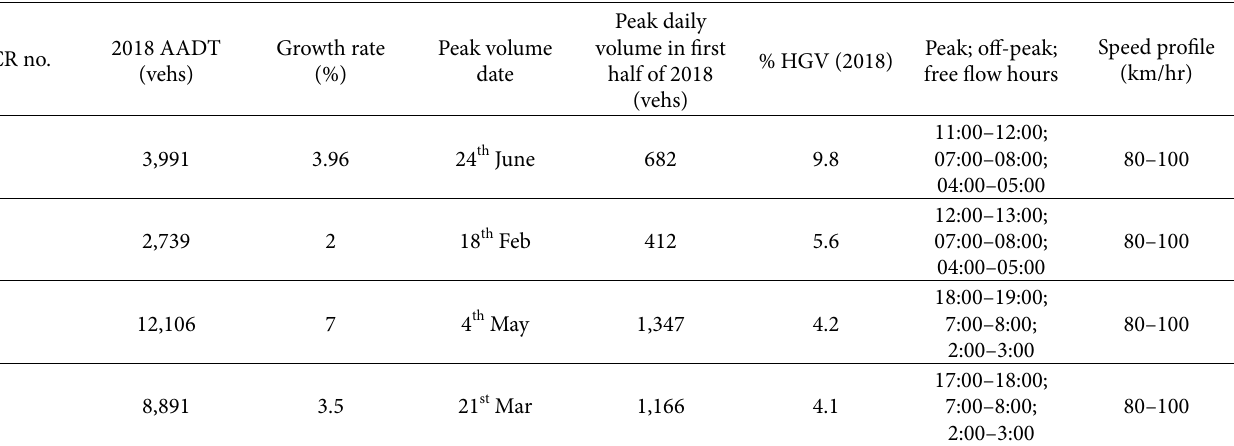
Table 4: Base data for CL3‐6.